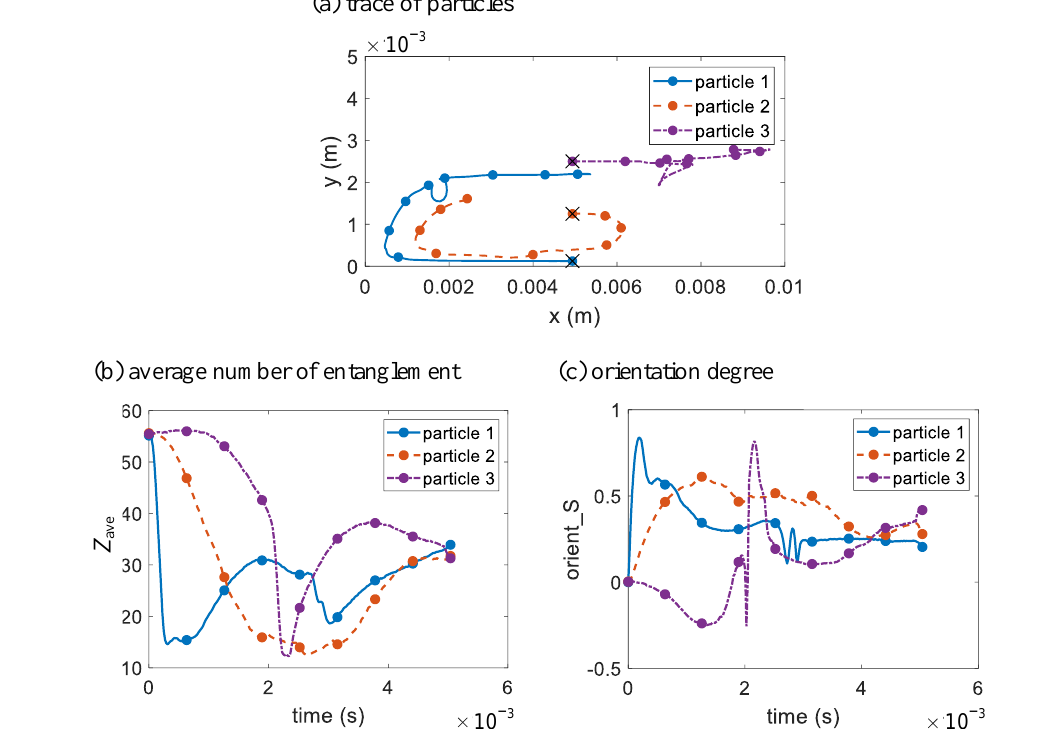
Figure 10. The multiscale simulation results of ( a ) particle traces and the changes in ( b ) average number of entanglements and ( c ) orientation degree over time of 3 chosen melt particles in the rectangular cavity with circular obstacle.